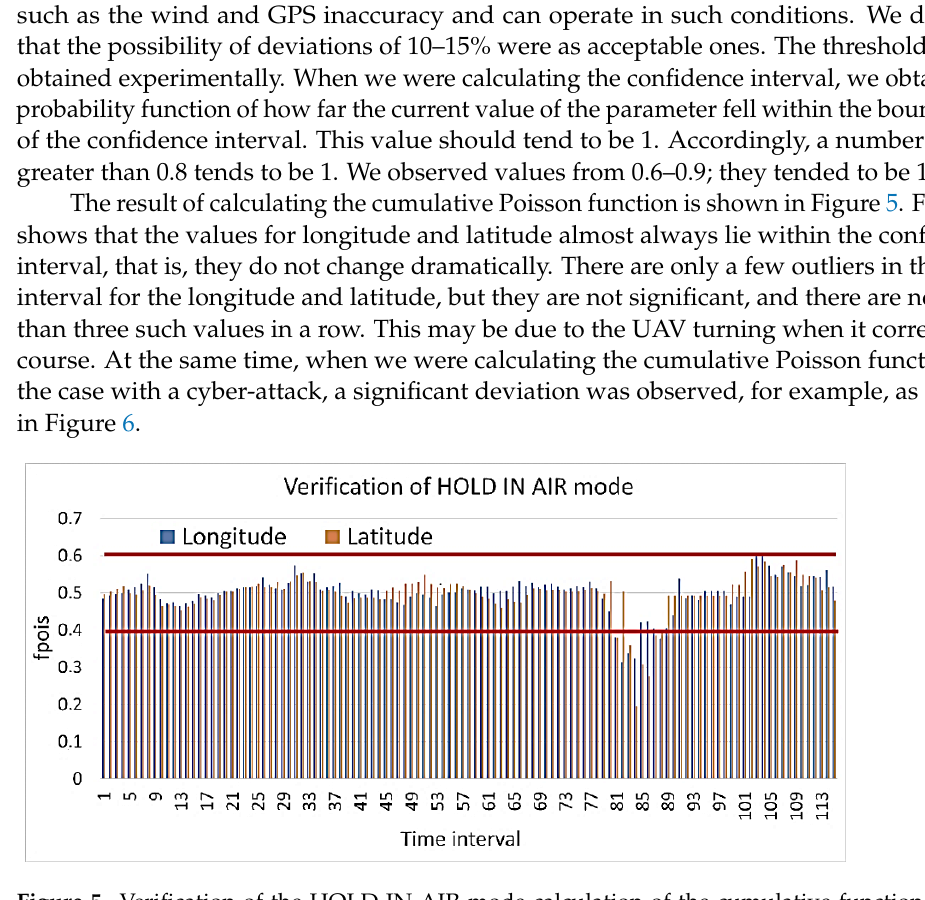
Figure 5. Verification of the HOLD IN AIR mode calculation of the cumulative function for the Poisson distribution.